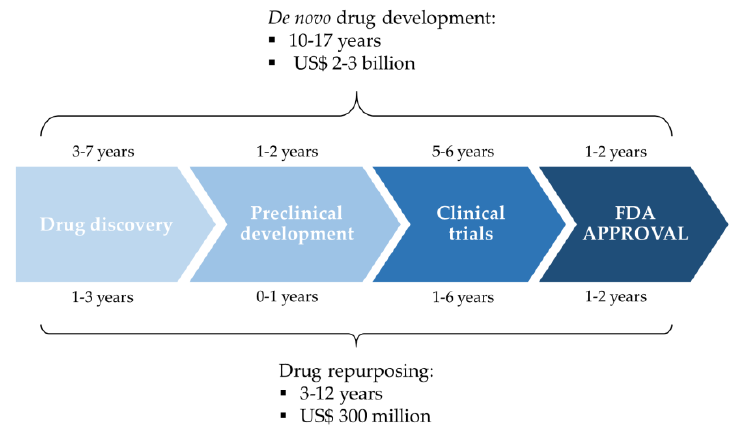
Figure 1. Comparison between de novo drug development and drug repurposing. Adapted from Ashburn and Thor [22].